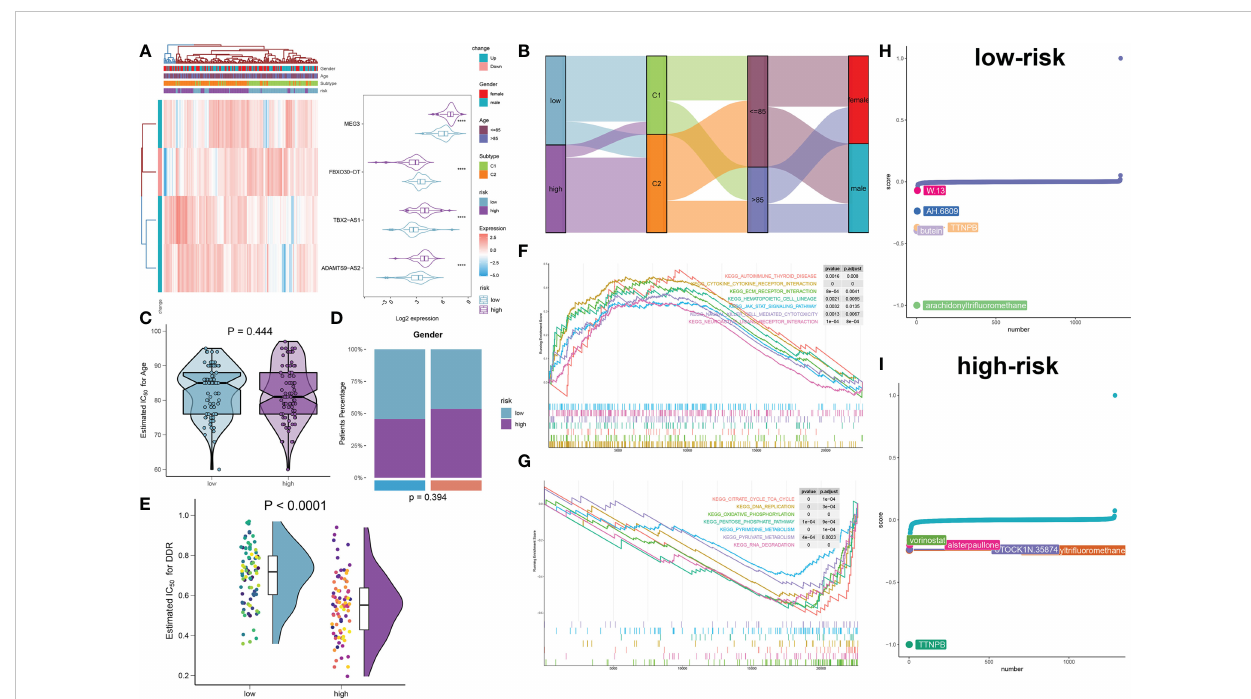
FIGURE 11 Construction and molecular characteristic of a risk model. (A) Heatmap displaying the expression pro fi les of 4 characteristic lncRNAs associated with DDR between low- and high-risk AD patients. Age, sex, and DDR subtypes were exhibited as patient annotations. (B) The sankey diagram illustrating the association between riskScore, DDR subtypes, age, and gender. (C, D) Age (C) and gender (D) distribution differences between AD patients at low and high risk. (E) Comparison of the DDR score in low- and high-risk AD patients. (F, G) GSEA revealing the elevated (F) and downregulated (G) main pathways in patients at low and high risk. (H, I) CMap study displaying the top 5 prospective treatment medicines for patients at low (H) and high (I)